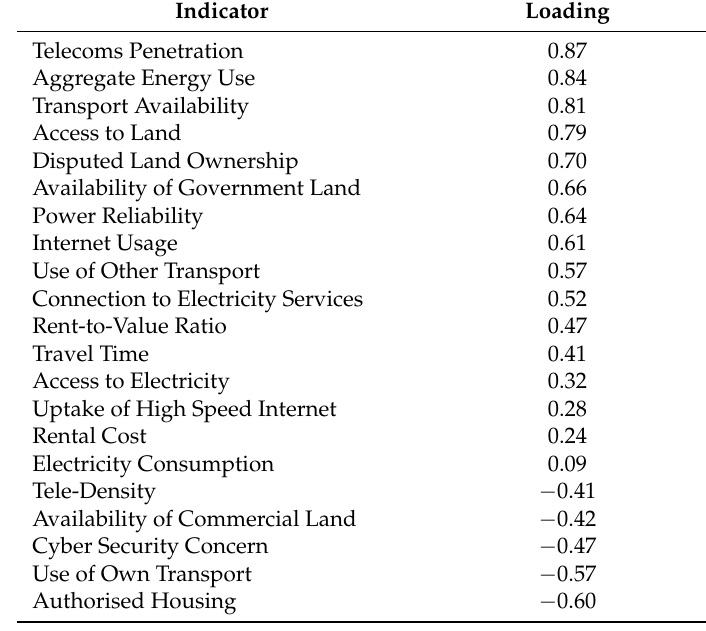
Table 8. Loading of the First Principal Component in Descending Order.